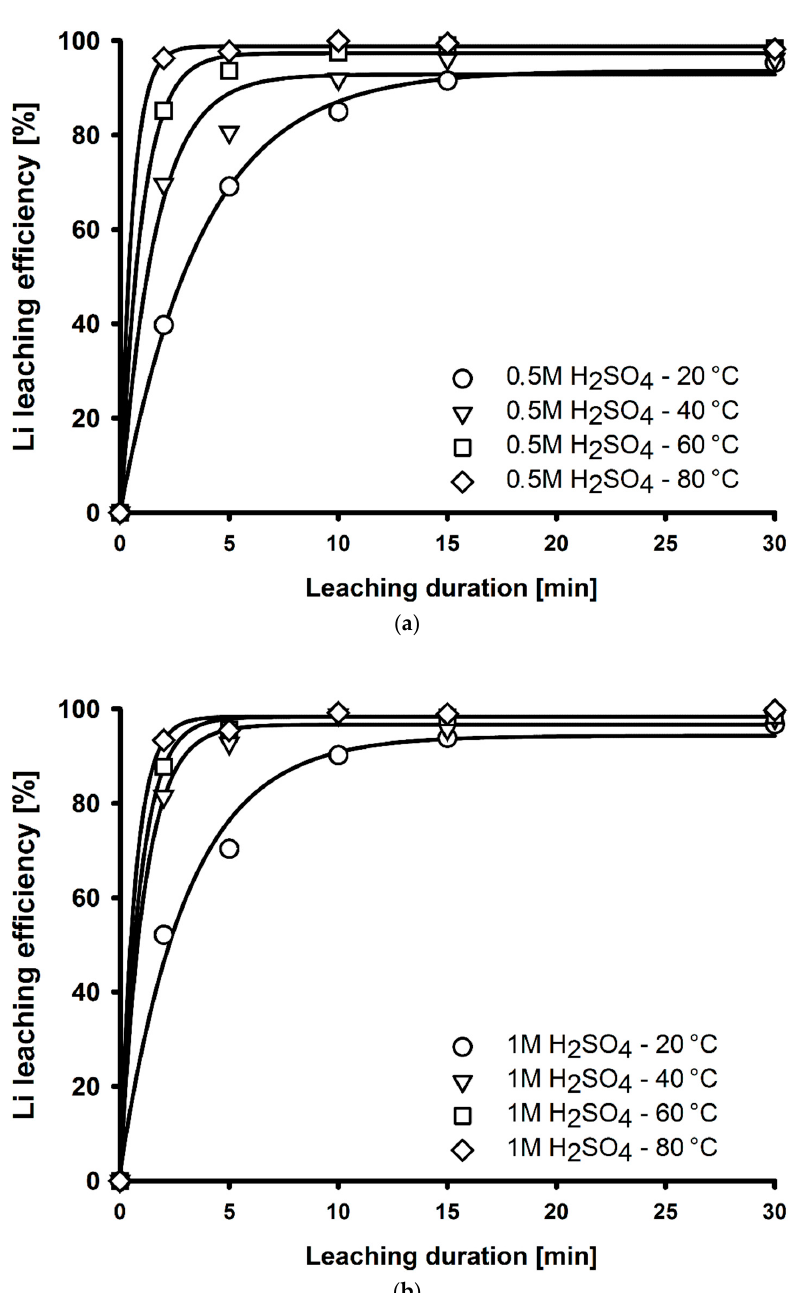
Figure 7. Lithium leaching e ffi ciency at 20–80 ◦ C in 0.5 M ( a ) and 1 M ( b ) H 2 SO 4